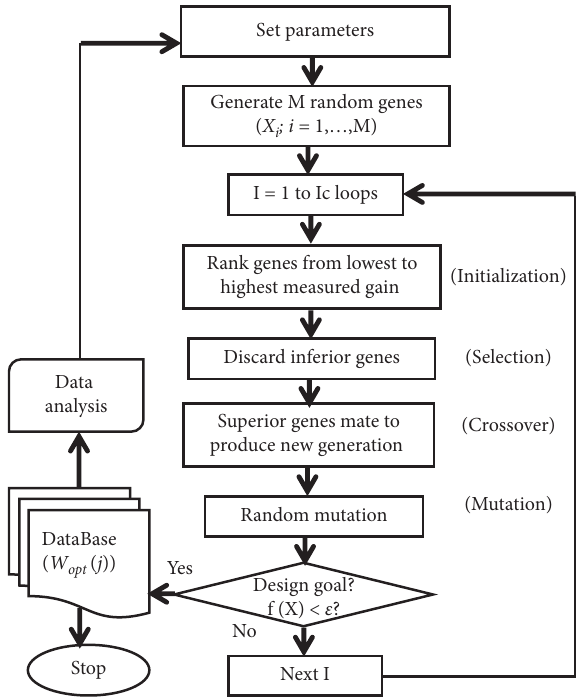
Figure 4: Flowchart of modified GA proposed in this